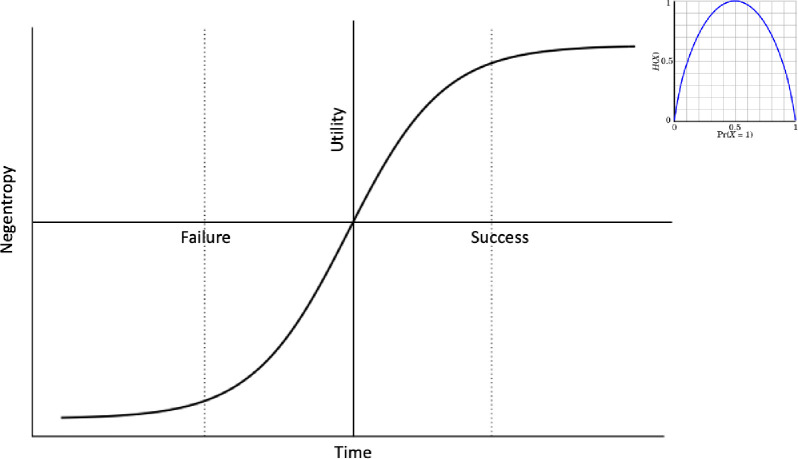
Utility function.